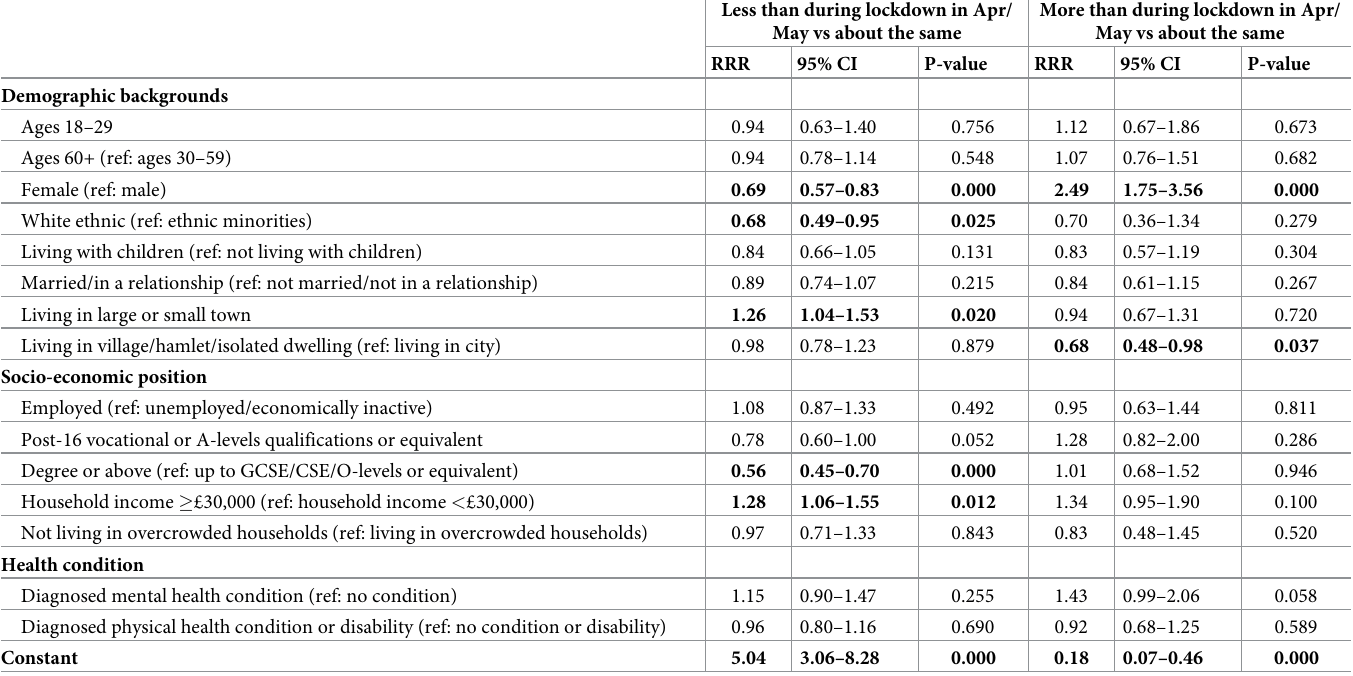
Table 4. Multinomial logistic regressions comparing arts engagements in the third lockdown (January/February 2021) with engagements in the first lockdown in April/May (2020) (N = 13,270).